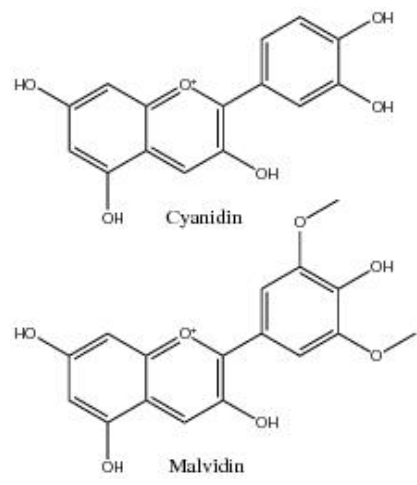
Figure 2. Cyanidin and malvidin, anthocyanidins of cotton.